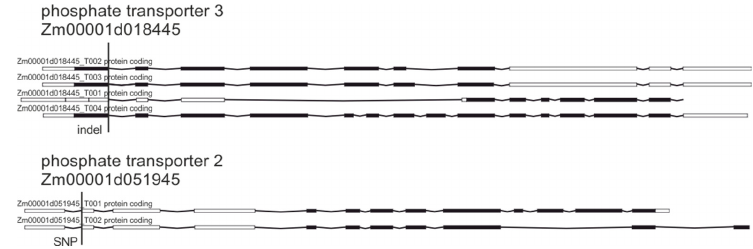
Figure 6. Genetic variations in phosphate transporter genes.